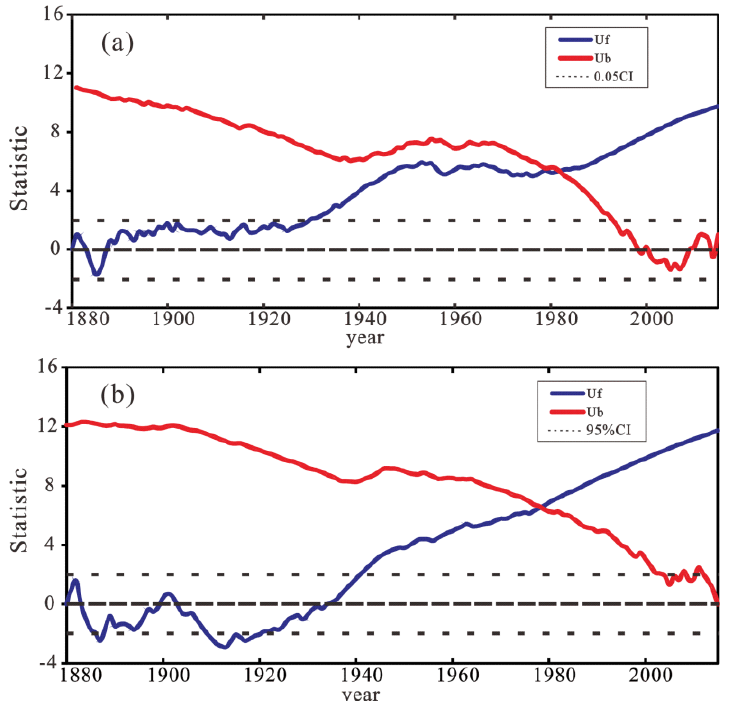
Figure 3. The result of the Mann-Kendall test (M-K test) of the temperature in Shanghai and globally: ( a ) M-K test of Shanghai mean temperature; and ( b ) M-K test of global mean temperature.